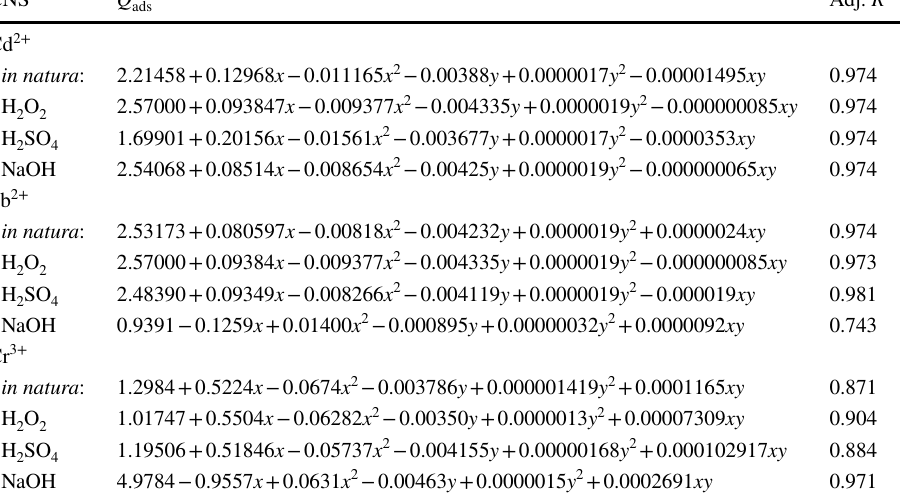
Table 6 Equation for adsorbed quantity ( Q ads ) of Cd 2+ , Pb 2+ and Cr 3+ by CNS adsorbents